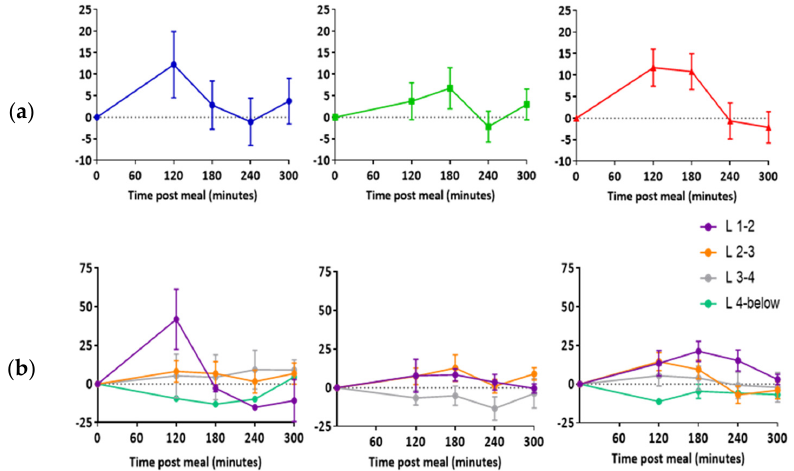
Figure 5. Change in lymph node apparent diffusion coefficient post high fat meal. ( a ) Data represent the average difference between individual lymph nodes (mean ± SEM). ( b ) Data represent the average difference between individual lymph nodes at each vertebra level (mean ± SEM). L = lumbar vertebra. n = 11 for participant 1, n = 22 for participant 2, and n = 33 for participant 3.